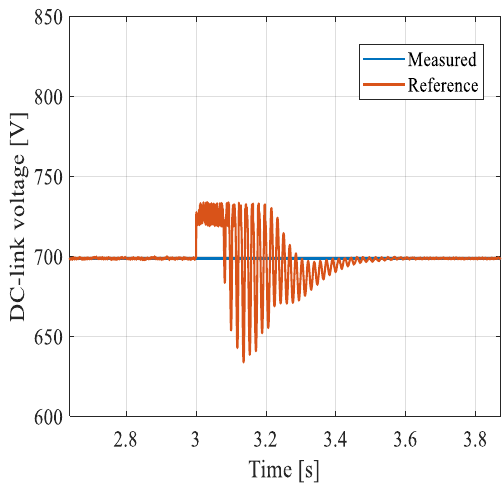
Figure 8. DC-link voltage during a balanced voltage sag.